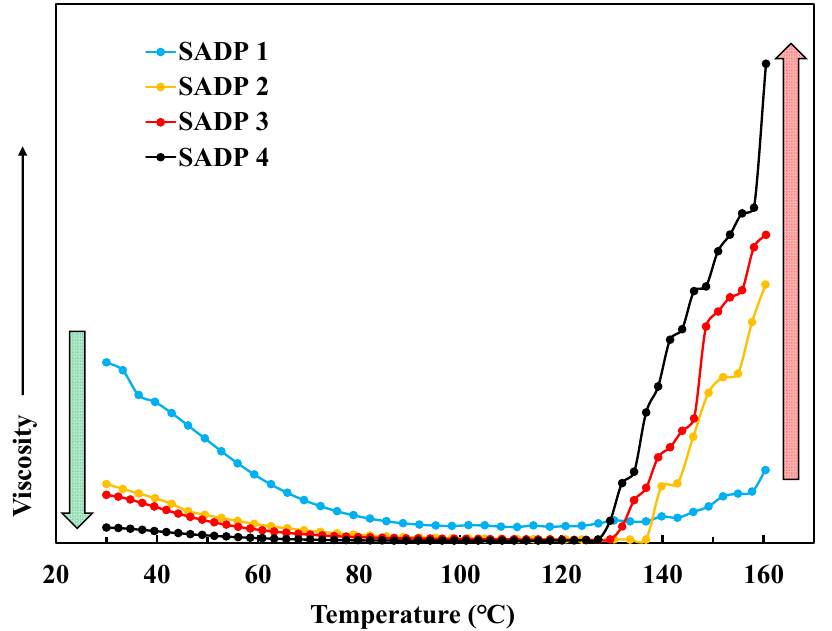
Figure 6. Viscosity ‐ temperature characteristics of SADP adhesive. Figure 6. Viscosity-temperature characteristics of SADP